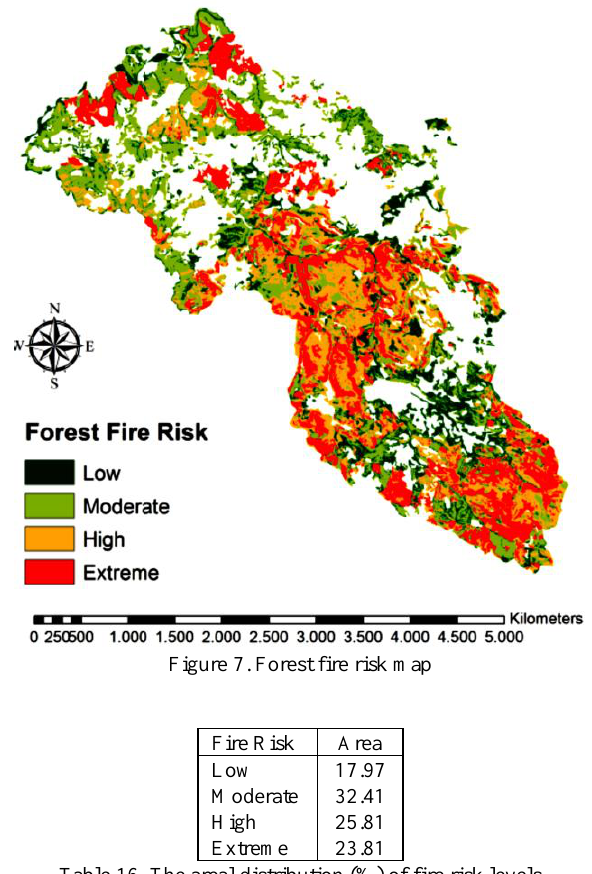
Table 16. The areal distribution (%) of fire risk